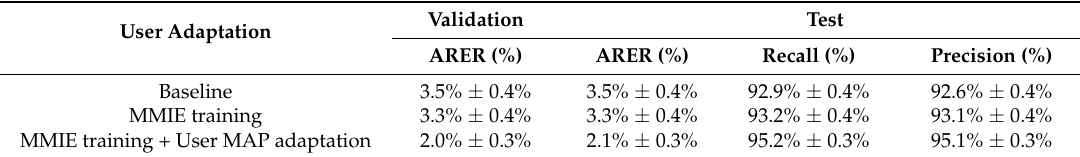
Table 2. Final segmentation results including activity recognition error rate (ARER), recall and precision